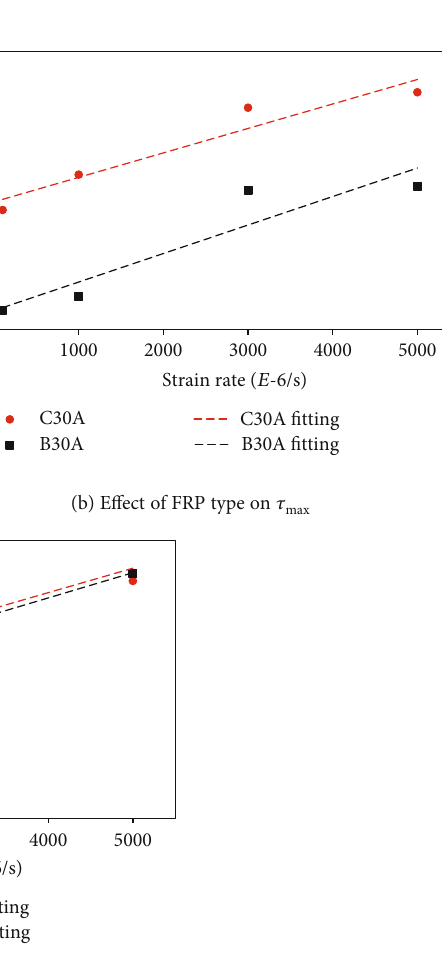
Figure 9: E ff ect of material properties on the strain e ff ect of G